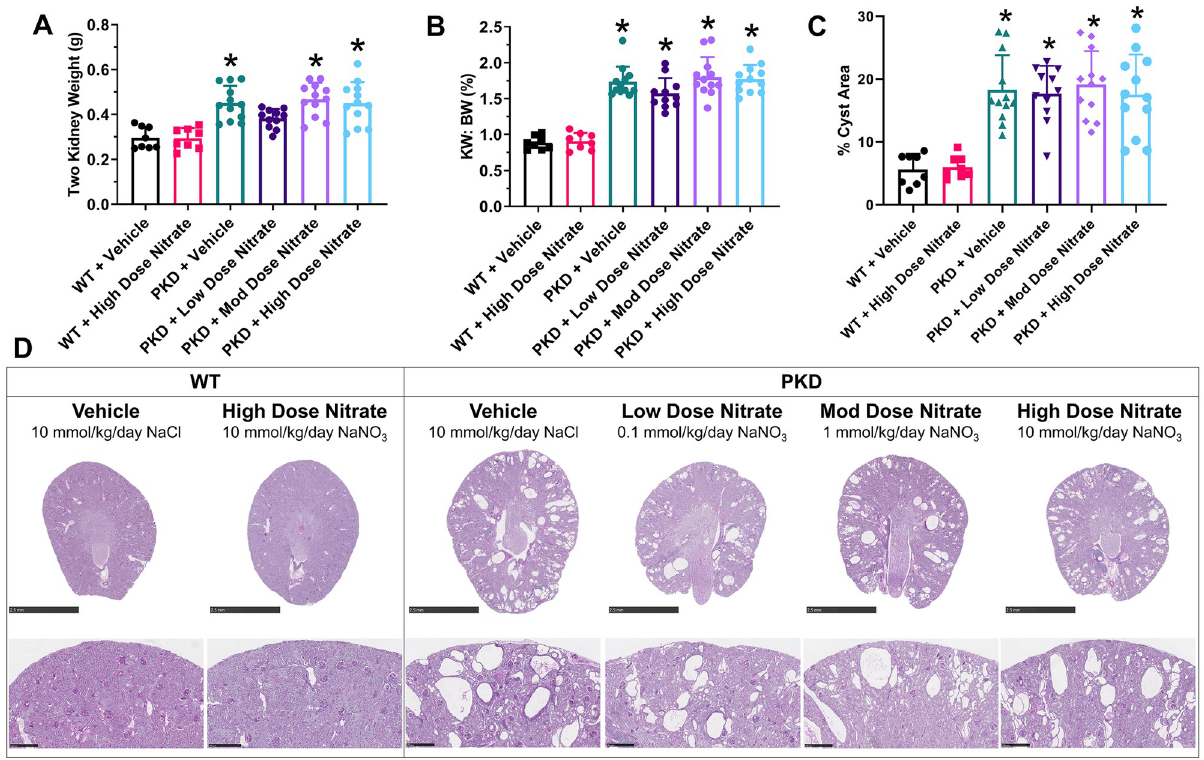
Fig 4. Kidney enlargement and histological analysis of cystic kidney disease in wild-type (WT) and Pkd1 RC/RC (PKD) mice treated with sodium chloride (vehicle) or sodium nitrate (low, 0.1 mmol/kg/day; moderate, 1 mmol/kg/day; high dose, 10 mmol/kg/day) for 8 months. (A) Two kidney weight; (B) Kidney weight to body weight ratio (KW: BW); (C) Percentage cyst area; (D) Representative whole-slide digital images of Periodic Acid Schiff (PAS)-stained kidney sections from male WT and PKD mice. � P < 0.05 compared to WT + Vehicle by one-way ANOVA, followed by post-hoc analysis with the Tukey Kramer HSD test. Data were combined from male and female mice (n = 4–6 per group per gender) and presented as means ± SD.